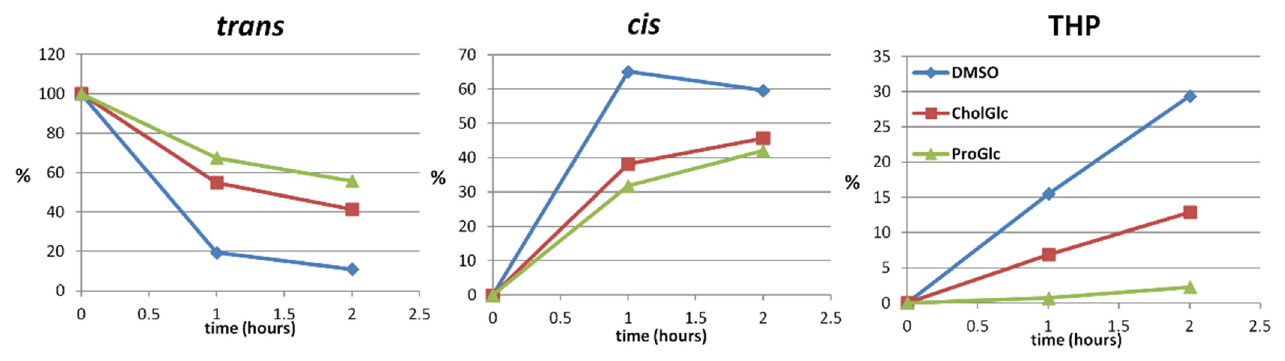
Figure 7. Resveratrol sunlight-induced photochemical isomerization and THP formation in the presence of different NaDES. DMSO was utilized as the control solvent.